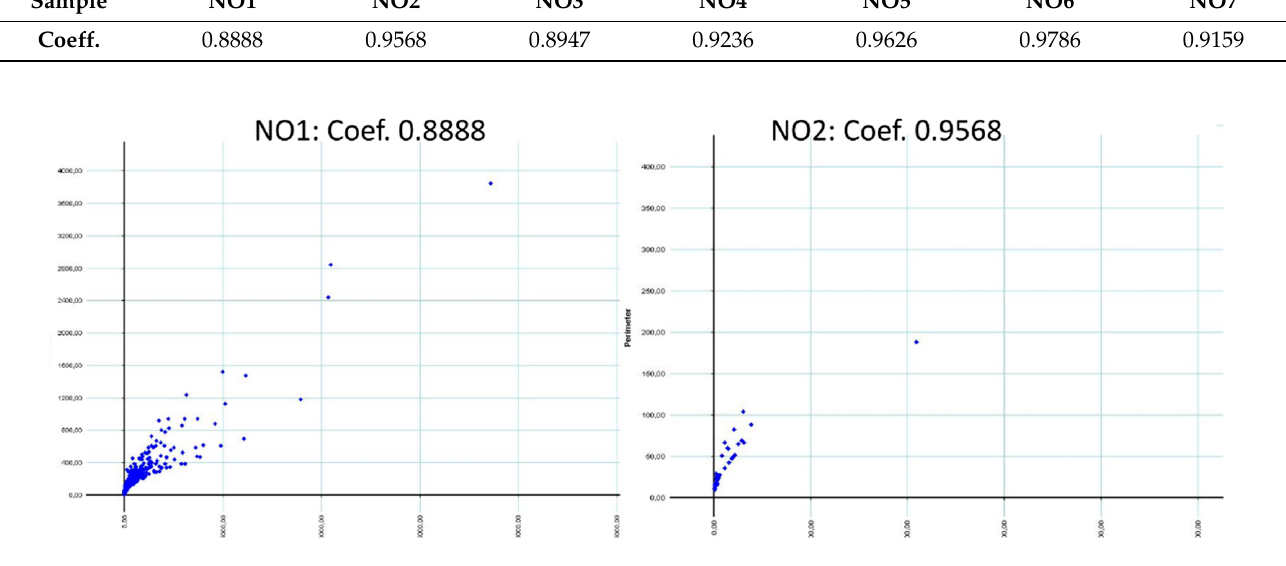
Figure 5. Graphs of the coefficient of sphericity in NO1 and 2, the most relevant results based on the area-to-perimeter ratio (JMicrovision Software). Two groups are found according to the sizes and 2D surfaces.